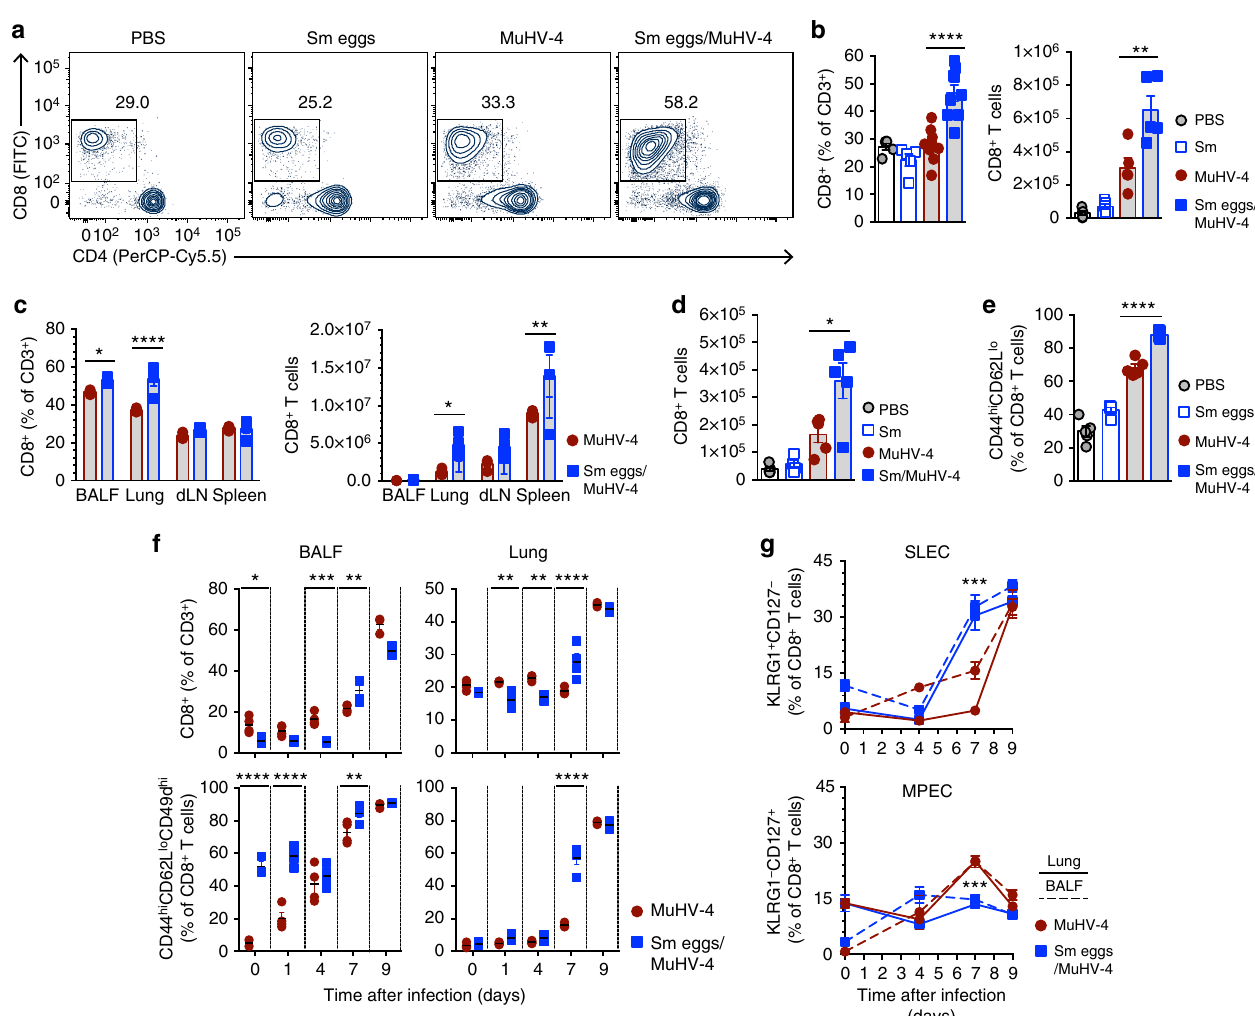
Fig. 4 S. mansoni egg immunization augments effector/memory CD8 + T cell responses to MuHV-4 infection. BALB/c mice were treated with S. mansoni (Sm) eggs as outlined in Fig. 3a ( a – c , e – g ) or infected with S. mansoni cercariae (35 cercariae per mouse, percutaneous infection; d ) before being infected with MuHV-4-luc virus. a Representative fl ow contour plots of gated lung CD3 + T cells at day 7 pvi. Gated population indicates the percentage of CD8 + T cells. b Percentage and numbers of lung CD8 + T cells at day 7 pvi as determined by fl ow cytometric analysis. c Percentage and numbers of CD8 + T cells at day 7 pvi in the indicated organs as determined by fl ow cytometric analysis. d Number of lung CD8 + T cells at day 7 pvi in mice infected with S. mansoni 7 weeks before MuHV-4 infection. e Percentage of lung effector/memory CD8 + T cells (CD44 hi CD62L lo ) as determined by fl ow cytometric analysis. f Percentage of BALF and lung CD8 + T cells at the indicated time points after MuHV-4 infection. g Percentage of short-lived (SLEC, KLRG1 + CD127 − ) and variance (ANOVA) and Sidak ’ s multiple-comparison test ( ** P < 0.01, *** P < 0.001, **** P < 0.0001). Data are representative of two to three